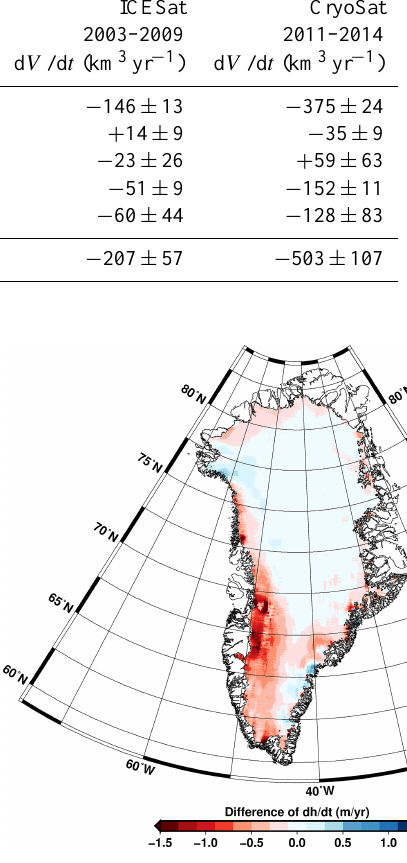
Figure 16. Difference of d h /d t between the period 2011 to 2014 and the period 2003 to